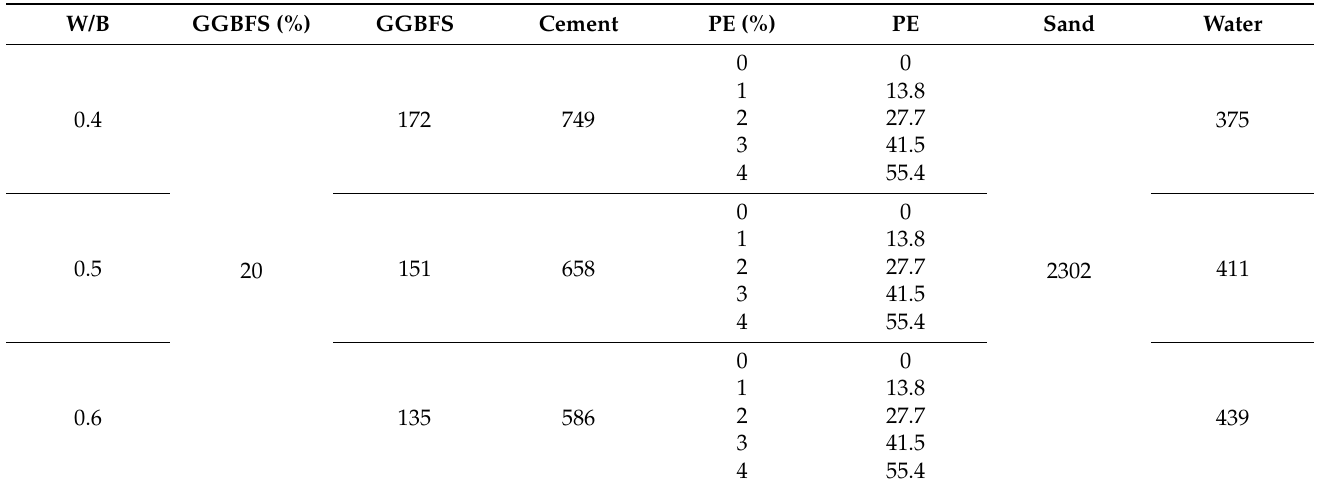
Figure 1. Material appearance and Fourier-transform infrared spectroscopy (FTIR) analysis of polyethylene. Table 1. Physical properties and chemical composition of test materials. Table 2. Mixture proportions of cement mortar (unit: kg/m 3 ).